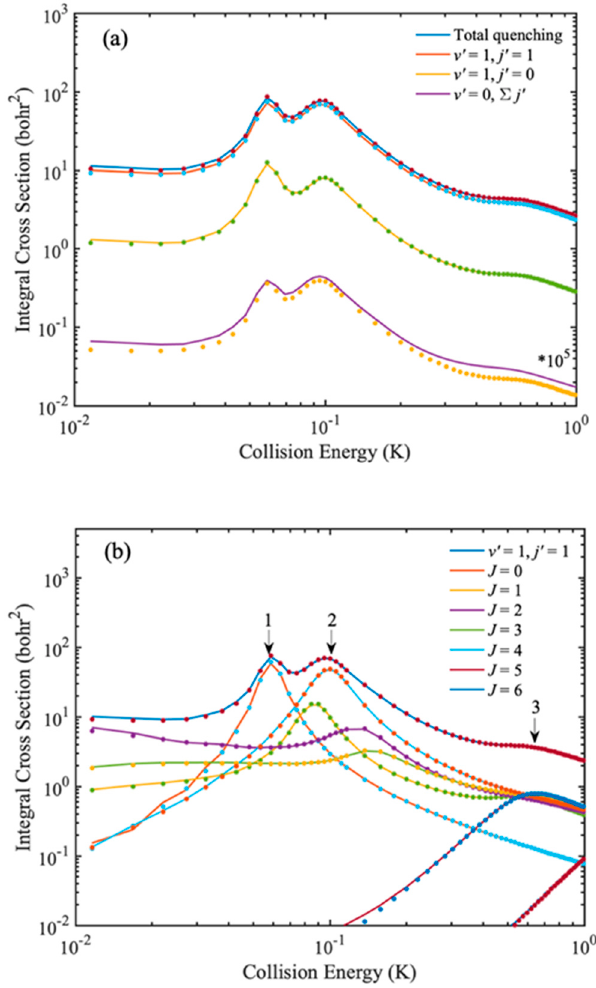
Figure 2. ( a ) State-resolved quenching ICSs of Na(3s) + HD( v = 1, j = 2) → Na(3s) + HD( v ′ , j ′ ) collision. ( b ) J resolved quenching ICSs of Na(3s) + HD( v = 1, j = 2) → Na(3s) + HD( v ′ = 1, j ′ = 1) collision. The solid and dot lines are obtained by IALR-WP method and TICC method, respectively. Table 1. Numerical parameters used in IALR-WP calculations for the Na(3s) + HD( v = 1, j = 2)